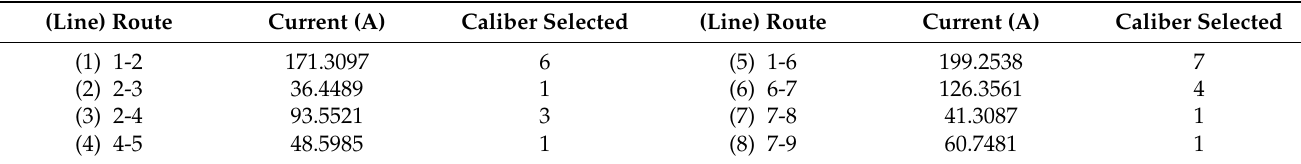
Table 4. Ideal current consumption for each